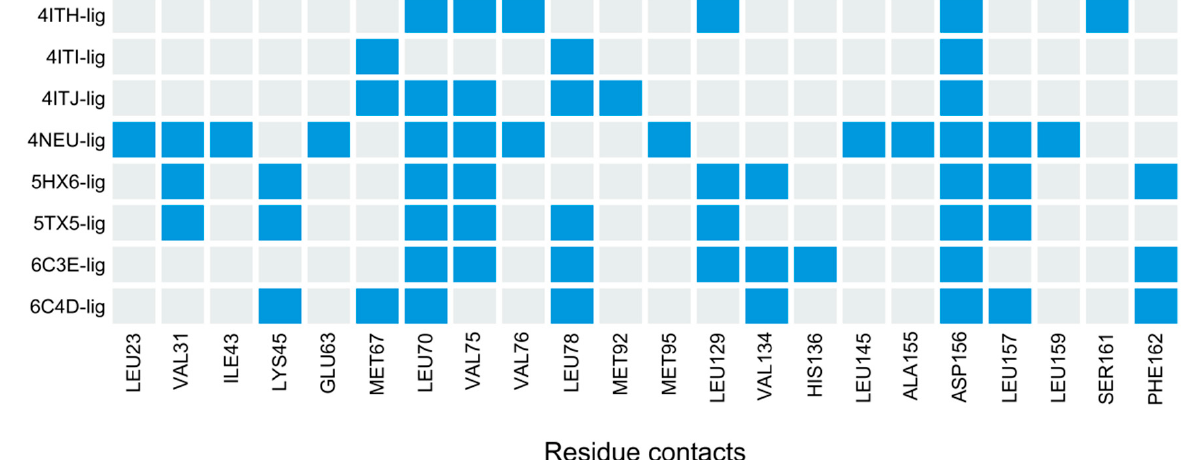
Figure 8. Enrichment curves for ChEMBL compounds, produced using PLIF similarities calculated from docking contacts with RIPK1 (5HX6, 50 poses). PLIF similarities were calculated with all resi- due contacts (N = 81 residues) portrayed by the grey curve, versus the six key residues that indicated frequent interactions among all crystal structures (i.e., LEU70, VAL75, LEU78, LEU129, ASP156, ASP157), portrayed by the red curve. Larger similarity ranking values on the X-axis corresponds to higher similarity. In an attempt to further improve the enrichment rate of the “all residues” curve in Figure 8 (grey curve), we attempted to reduce the number of residues considered in the PLIF similarity measurements, as some of the contacts might be solely a result of particu- lar characteristics of the structure of the reference ligand, and thus not well generalizable to other compounds. To do so, we kept only the residues that interact with at least half of the crystal structures (Figure 7), which resulted in the selection of six residues: LEU70 (seven ligands), VAL75 (six ligands), and LEU78 (five ligands) which belongs to the bind- ing loop, LEU129 (five ligands) which belongs to the α E helix, and finally ASP156 (eight ligands) and LEU157 (N ligands) which are the catalytic residues belonging to the DLG/DFG motif found in the activation loop. LEU157 also participates in the regulatory spine and regulates the access to the active site pocket [13]. Recalculating the similarity using exclusively these six residues slightly improved the enrichment curve (Figure 8, red curve). From this analysis, we concluded that PLIF similarity ranking >80 (i.e., 80th per- centile) would be a good cut-off to select inhibitors, as it allowed for covering the largest number of compounds with sufficiently high enrichment (~80%) (this percentile cutoff corresponds to similarities above 83%).